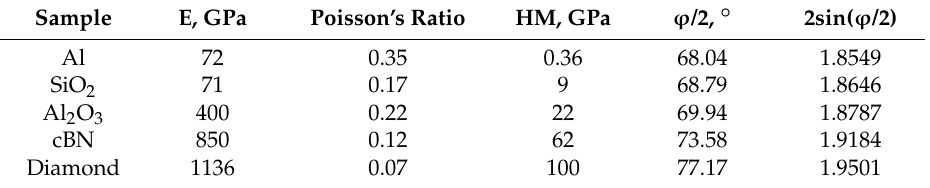
Table 1. The effect of elastic deformation of Vickers indenter on its geometry for some materials. Sample E, GPa